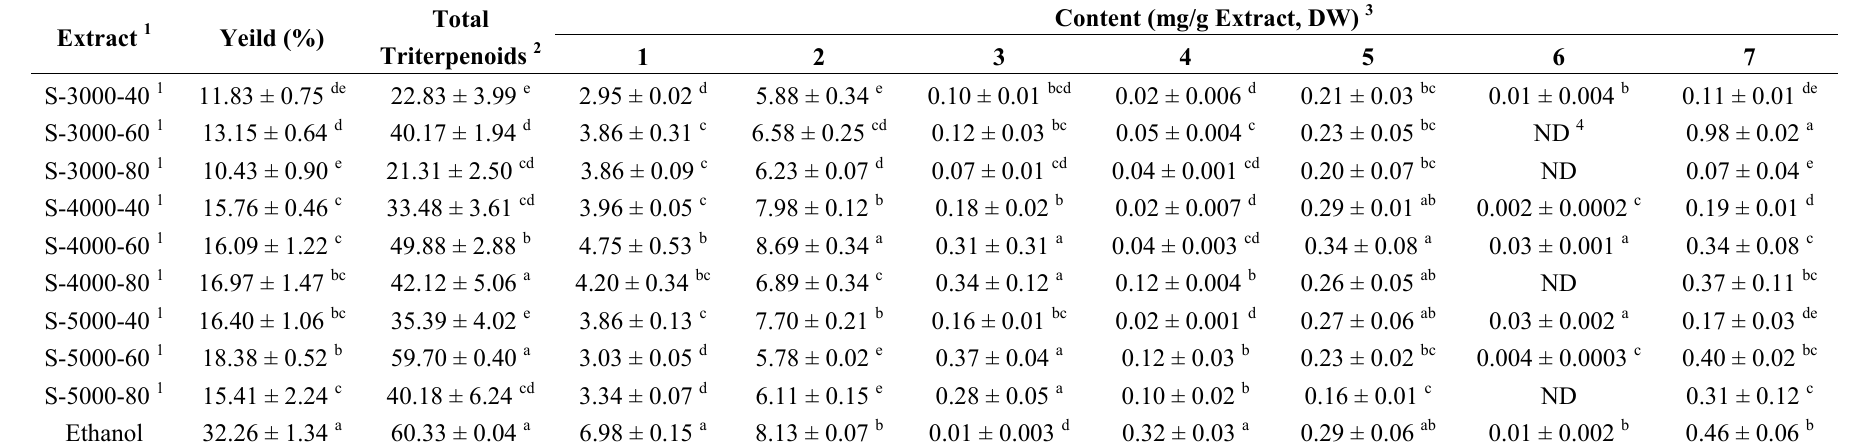
Table 1. Yield, total triterpenoids, contents in A. cinnamomea solid culture extracts obtained under different supercritical fluid and ethanol solvent extraction